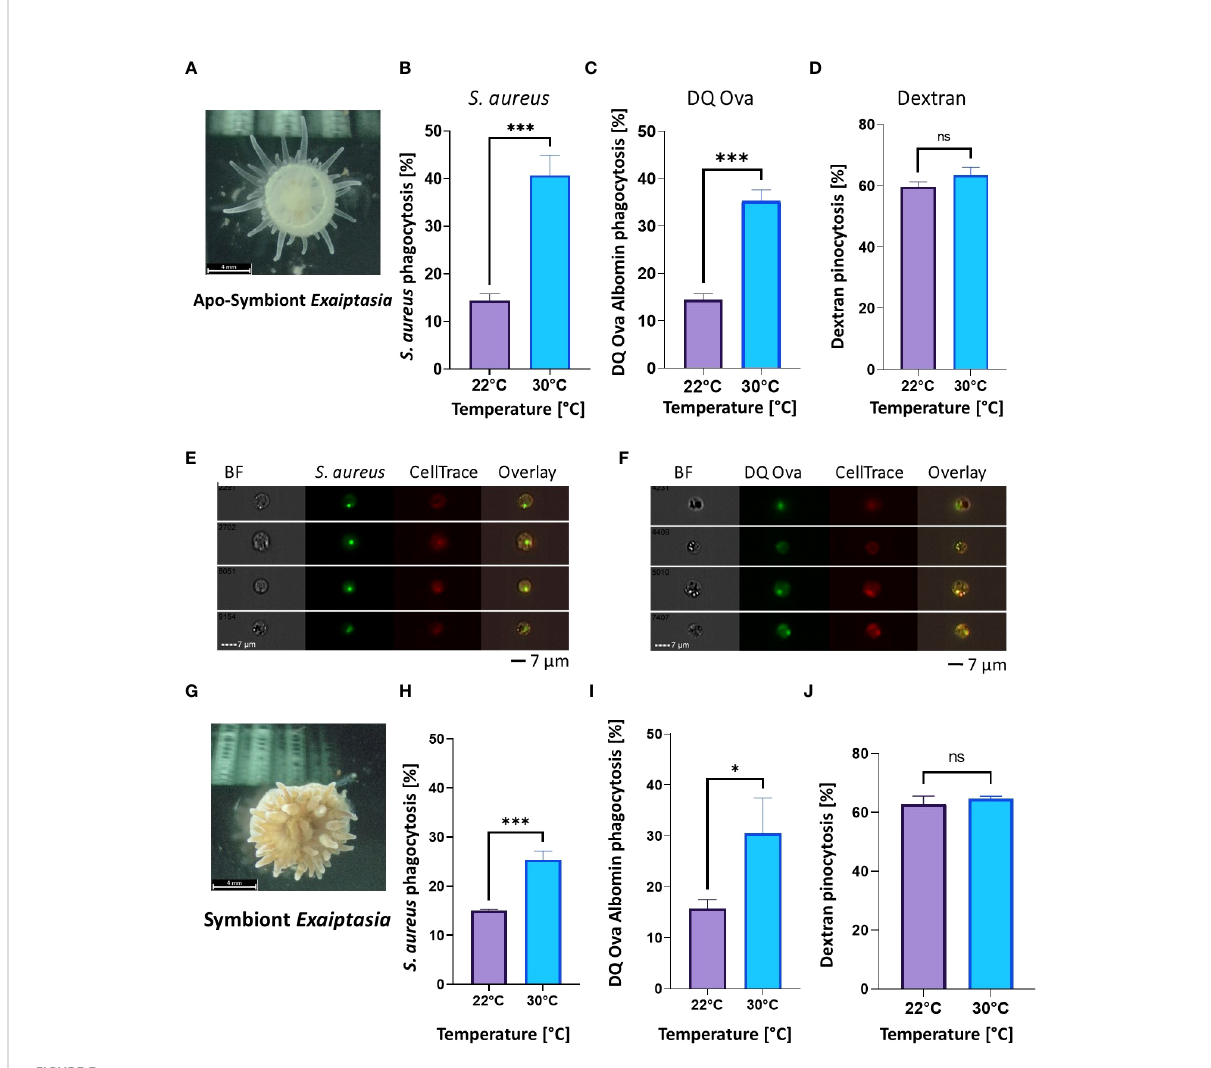
FIGURE 3 Phagocytic activity increases in heat stress conditions, while pinocytosis remains unchanged in both aposymbiotic and symbiotic E. diaphana . (A) Aposymbiotic E. diaphana imaged by ZEISS Axiocam 208 Color Microscope Camera. (B, C) Phagocytic cell activity in aposymbiotic E. diaphana of S. aureus particles (B) and DQ ovalbumin (C) is signi fi cantly higher under heat stress conditions 30°C, compared to ambient conditions of 22°C. (D) Pinocytosis of dextran in aposymbiotic E. diaphana under normal and heat stress conditions are not signi fi cantly different between ambient (22°C) and thermal stress conditions (30°C). (E, F) Phagocytosis images by Image stream analysis for aposymbiotic E. diaphana of S. aureus particles (E) and DQ ovalbumin (F) . (G) Symbiotic E. diaphana imaged by ZEISS Axiocam 208 Color Microscope Camera. (H, I) Phagocytic activity in symbiotic E. diaphana of S. aureus particles (H) and DQ ™ ovalbumin (I) is signi fi cantly higher under heat stress conditions (30°C), compared to ambient (22°C). (J) Pinocytosis of dextran in symbiotic E. diaphana under normal and heat stress conditions are not signi fi cantly different. A Student ’ s t-test analysis was performed on the phagocytic and the pinocytosis assays comparing the ambient and elevated temperatures. P-value legend: ns, Not signi fi cant, *: p <0.05, ***: p < 0.001. Scale bar represents standard deviation